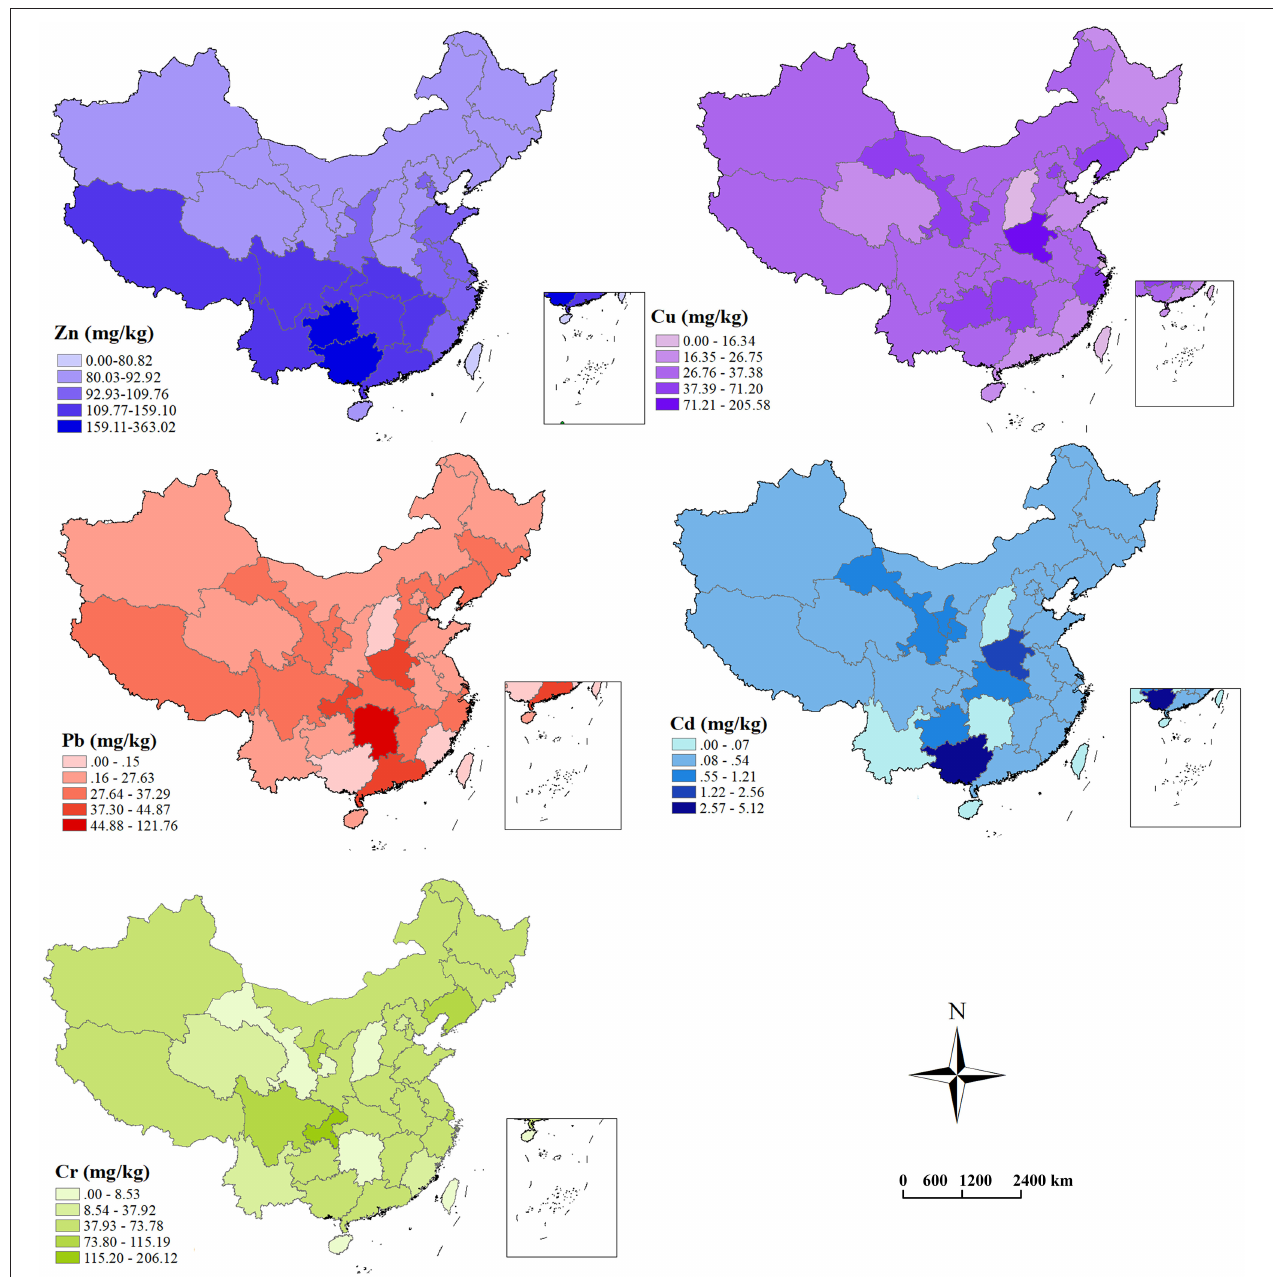
FIGURE 4 | The heavy metal concentrations in the farmland soil in different areas.